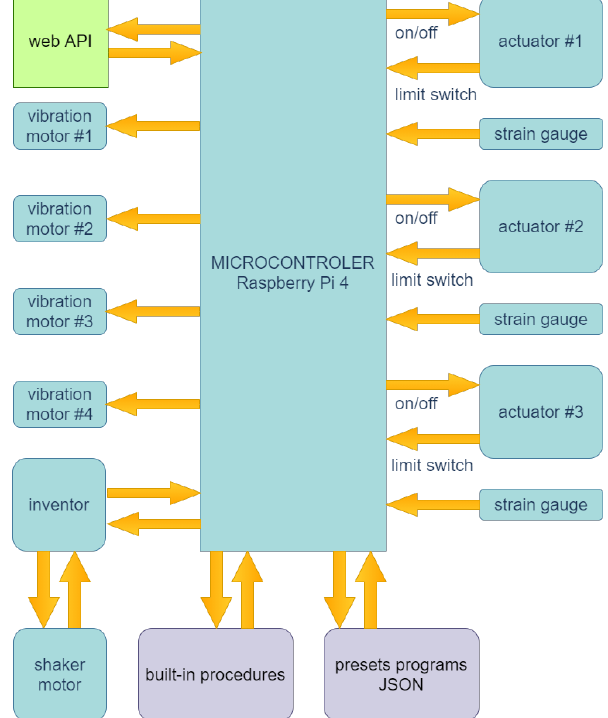
Figure 2. Functional block diagram of a mechatronics system.